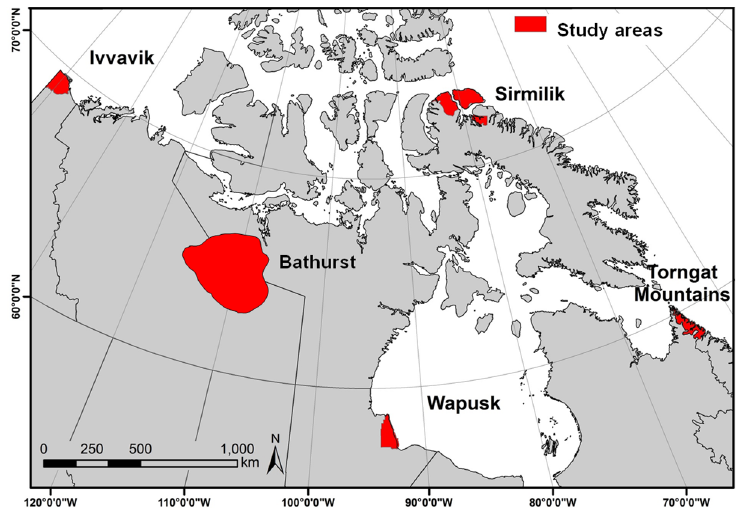
Figure 1. The distribution of five study areas in arctic Canada: three mountainous national parks (i.e., Ivvavik, Sirmilik, and the Torngat Mountains) and two relatively flat areas (i.e., Wapusk National Park, and Bathurst caribou summer range and calving ground). Table 1. List of study areas, their attributes, and the closest climate stations that have good data records. Latitude/Longitude at the Study Area Area (km 2 ) Venter